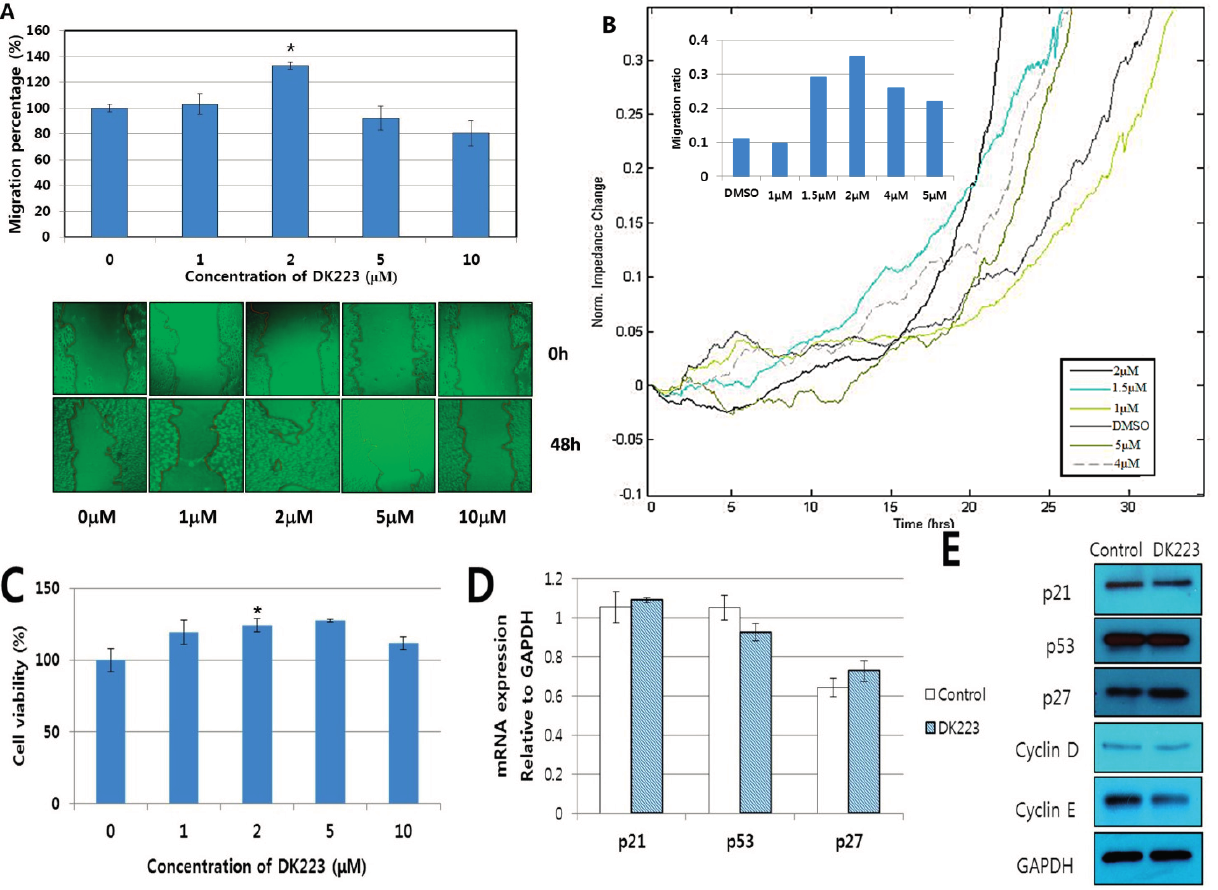
Figure 1. Effect of DK223 on the migration and proliferation of HaCaT cells. ( A ) Cells were seeded at a density of 3 × 10 4 /mL 24 h before the scratch test. Scratch widths were measured 48 h after DK223 treatment. Data represent the mean width percentage ± SD for at least three replicates, * p < 0.05; ( B ) Cells were seeded at a density of 3 × 10 4 /mL 24 h before treatment. The impedances were measured and analyzed at 24 h after treatment using the ECIS system software. The line data indicate the migration velocity of cells treated with different concentrations of DK223; ( C ) Cells were seeded overnight before treatment with varying concentrations of DK223 for 48 h. Cells were then incubated with MTT for 4 h at 37 °C, and the absorbance was measured at 570 nm; ( D , E ) The expression of cell cycle-related proteins in HaCaT cells induced by 2 μ M DK223 for 24 h. Protein expression was examined by Western blot analysis with the specific antibodies indicated, and mRNA expression was assessed by RT-PCR with the gene-specific primers indicated. A histogram depicting the ImageJ data analysis results is shown. Values represent means ± SD of three independent experiments, * p < 0.05 compared with the control in all under